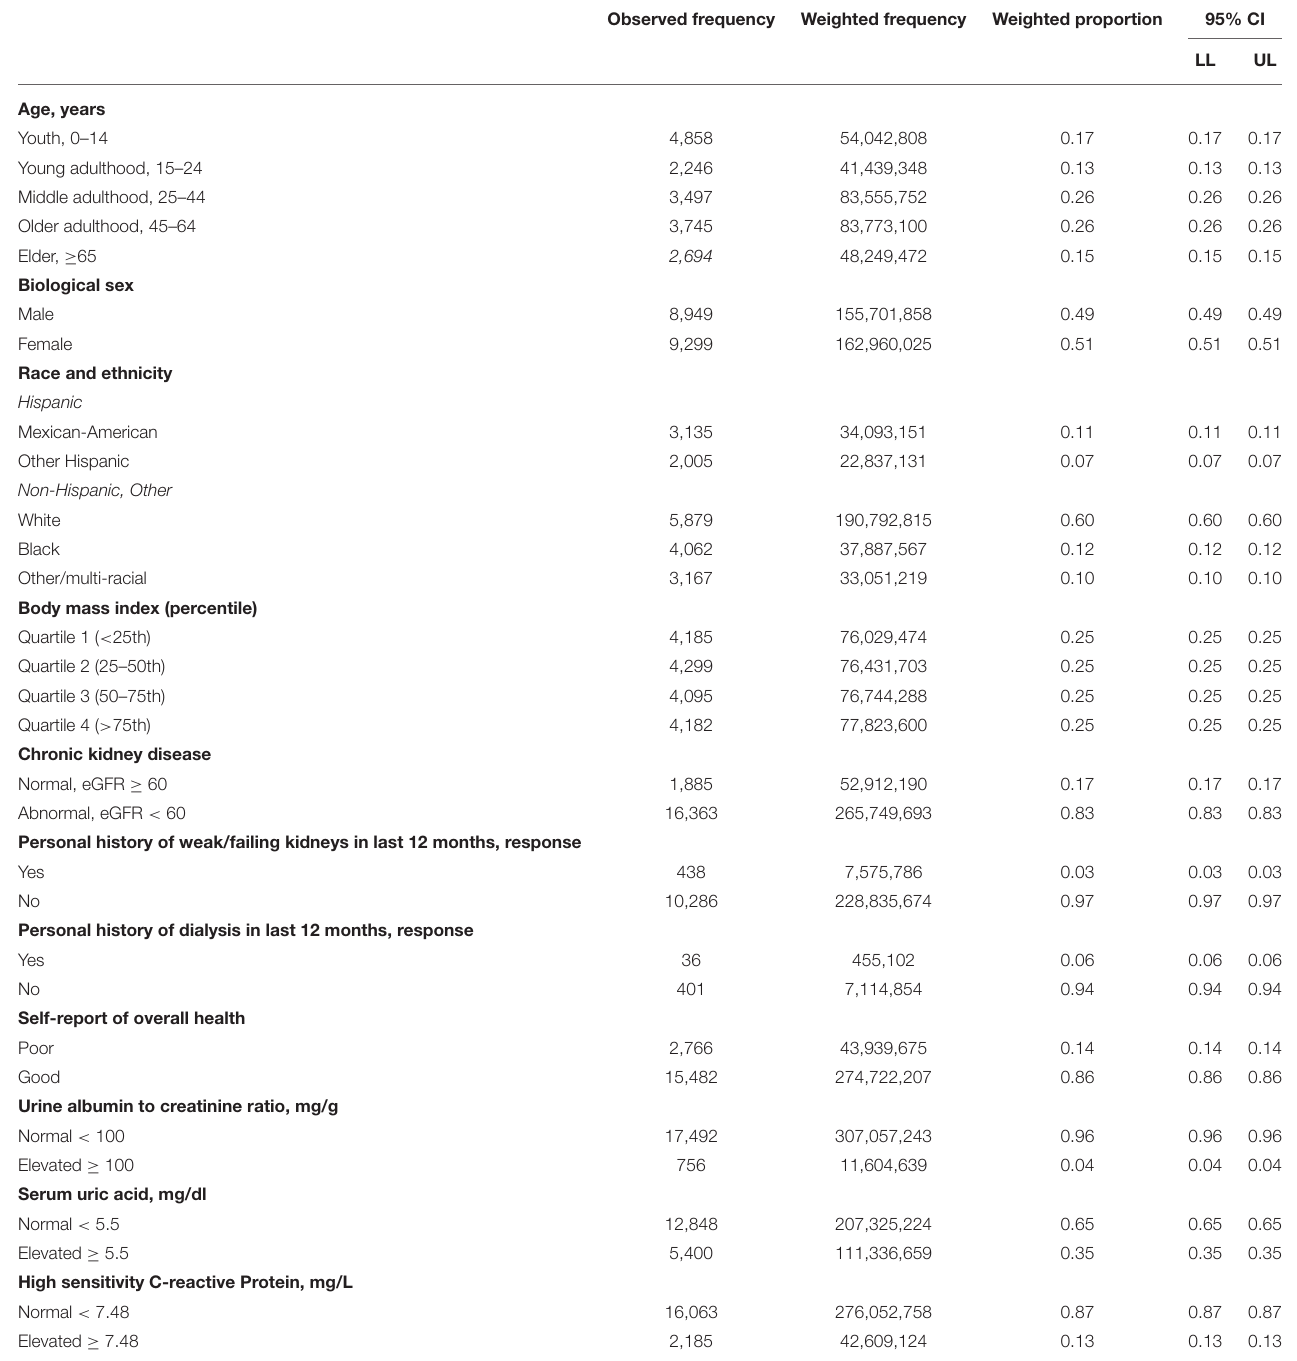
TABLE 2 | Summary